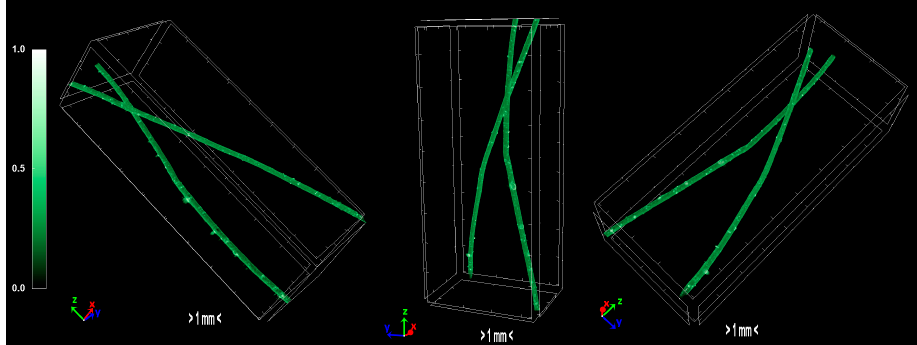
Figure 9. Micro-CT images of the HDPE/SKL (90:10) fibers.